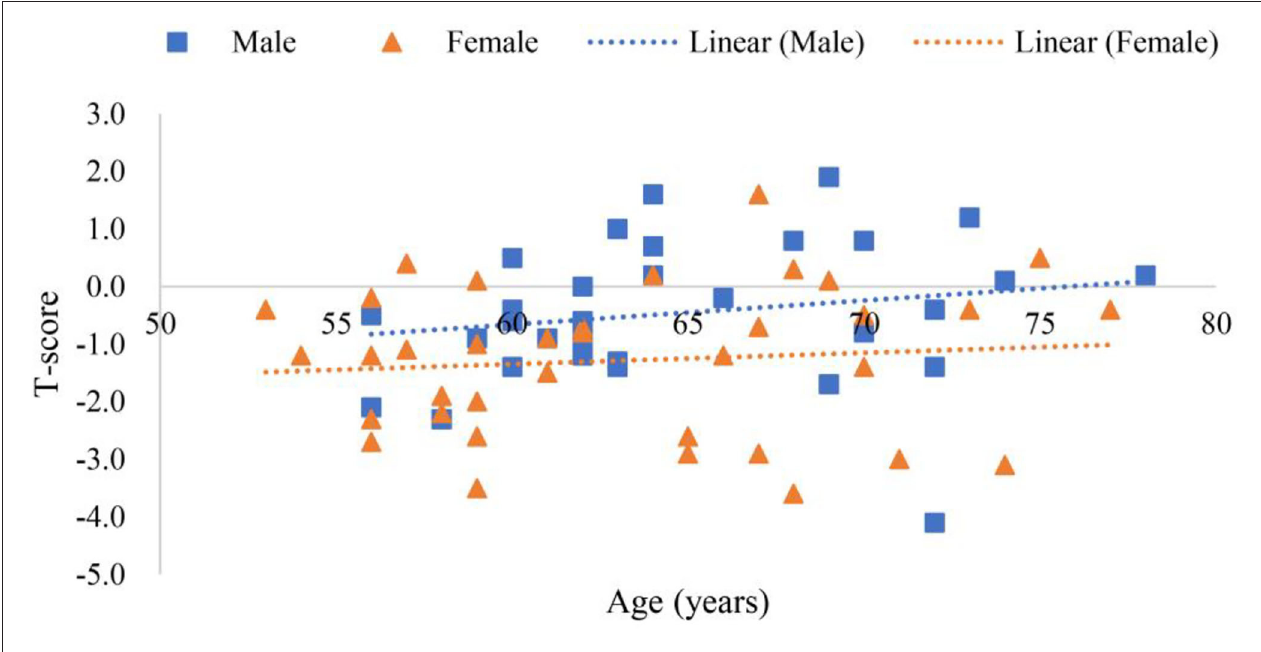
FIGURE 5 | Scatter plots of participants’ age and T -score.